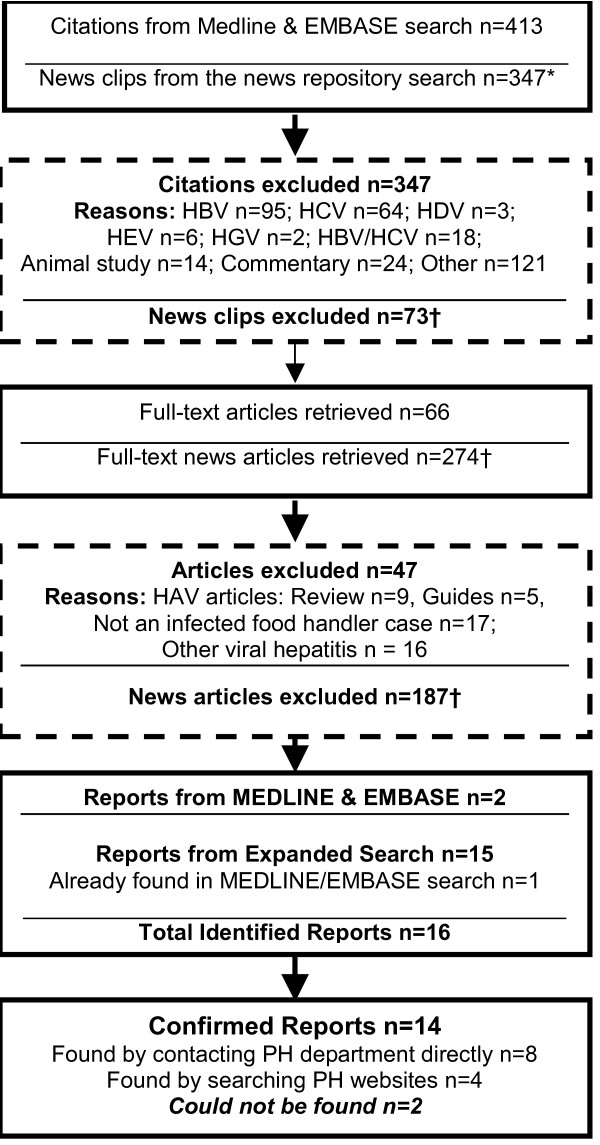
Study flow. Notes: *This number is an approximation due to the commercial coverage of media sources by the news repository. †Reason for exclusion of news clips and news articles were not categorized, as only the location and timing data were used.